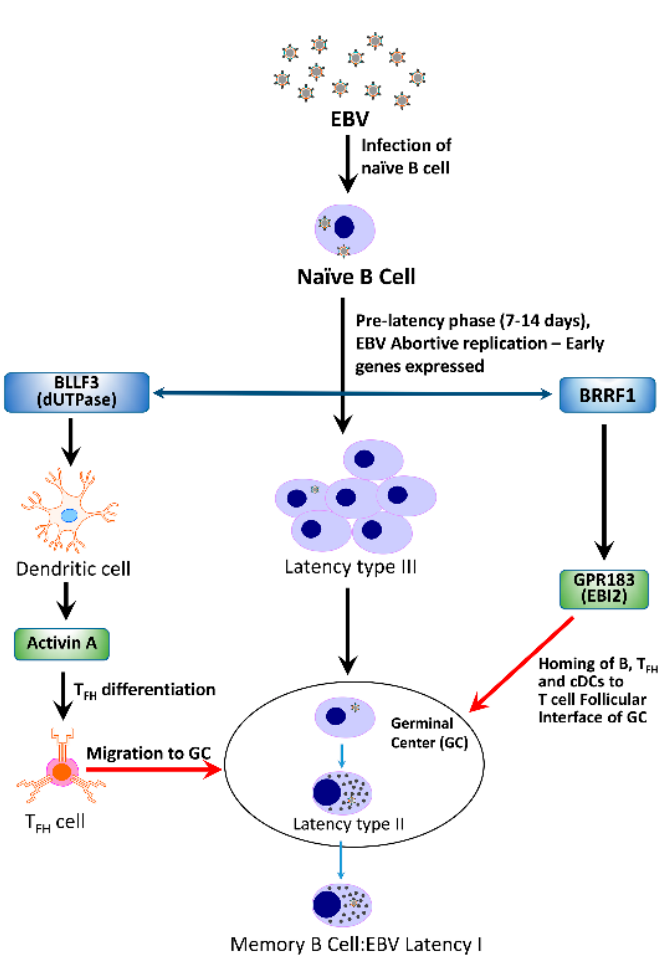
Figure 2. Hypothetical model depicting potential interactions between the EBV early proteins Na and dUTPase, encoded by BRRF1 and BLLF3 , respectively, and their contribution to the immune dysfunction observed in patients with ME/CFS.